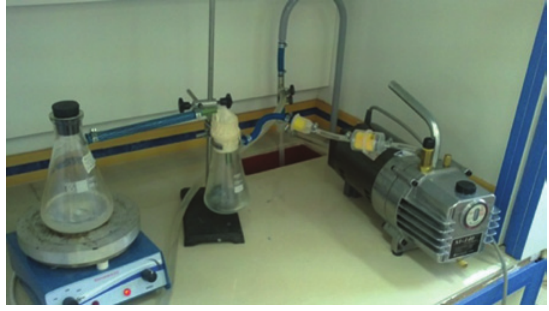
Figure 1: Mixing and solvent evaporation procedure under the vacuum